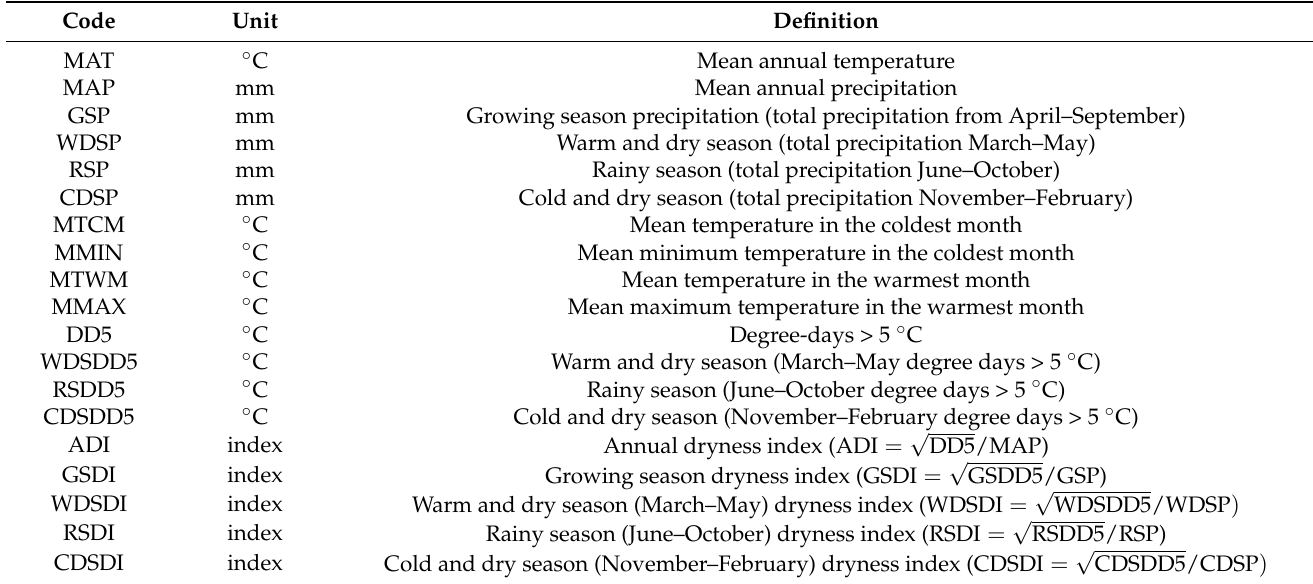
Table 2. Climatic variables estimated for each provenance (seed origin, taken from [40]) and for each test site (taken from data loggers HOBOs and rainwater capture data).